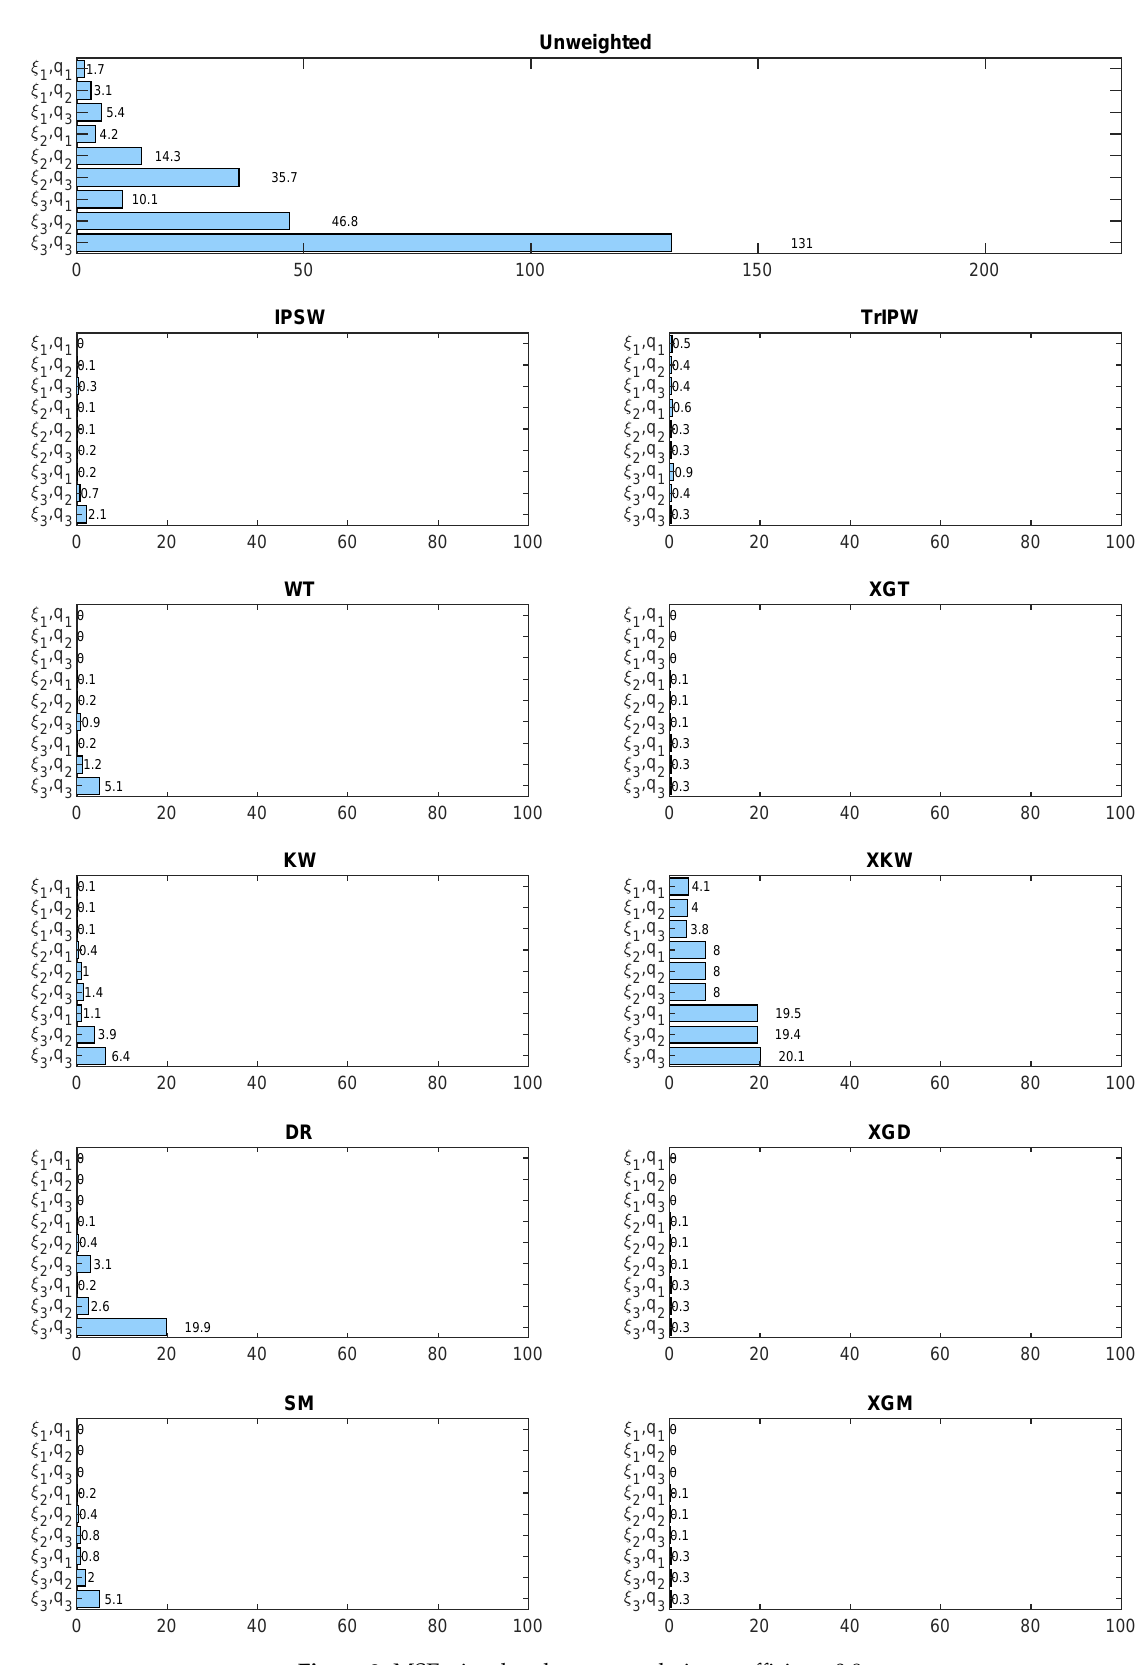
Figure 3. MSE, simulated case, correlation coefficient: